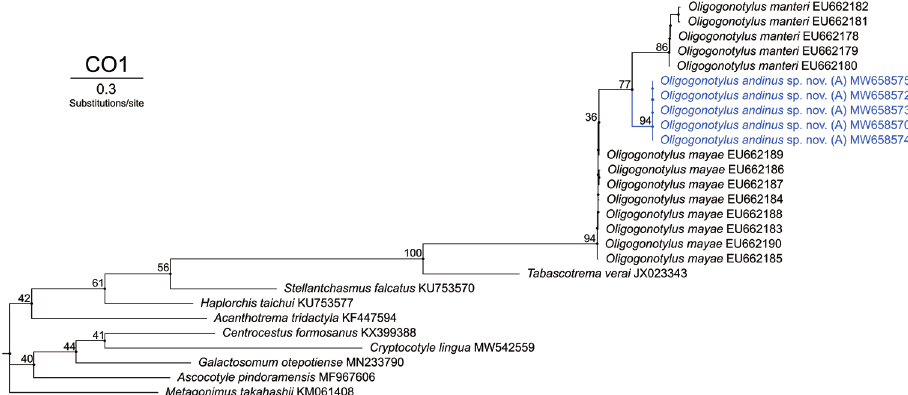
Figure 6. Phylogenetic relationships of COI sequences of Oligogonotylus andinus sp. nov., Oligogonotylus manteri , and Oligogonotylus mayae . Phylogenetic tree reconstructed using the maximum-likelihood method based on the general time reversible with gamma distribution model (GTR+G). Numbers on the branches correspond to the ultrafast bootstrap approximation support values. Each terminal is identified by the alphanumeric accession number of GenBank. Terminals in blue correspond to the sequences obtained in this report. Diagram made with IQ-TREE